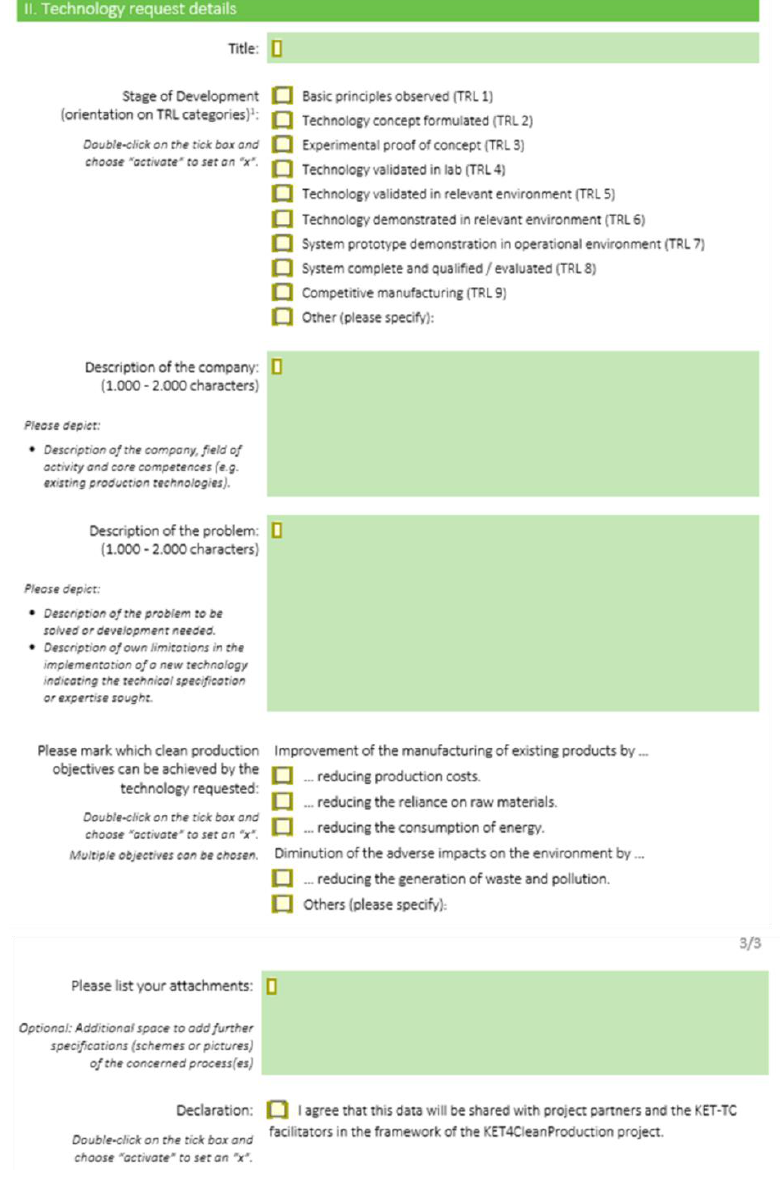
Figure A2. Second page template TR.